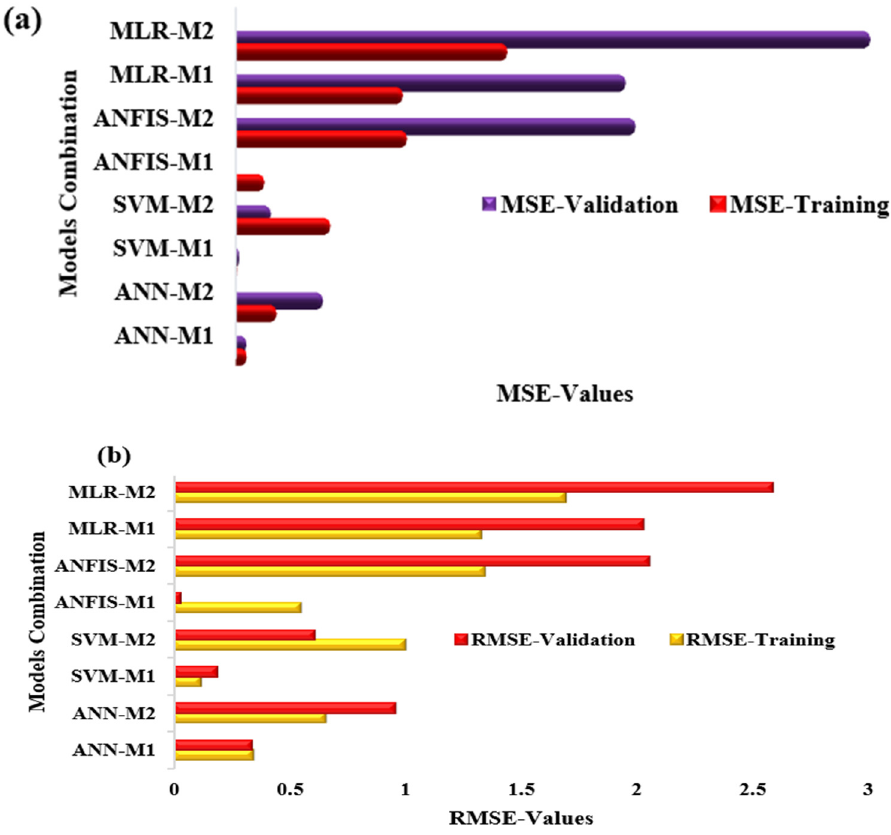
Figure 10. Error plot in both training and validation for ( a ) MSE and ( b ) RMSE.